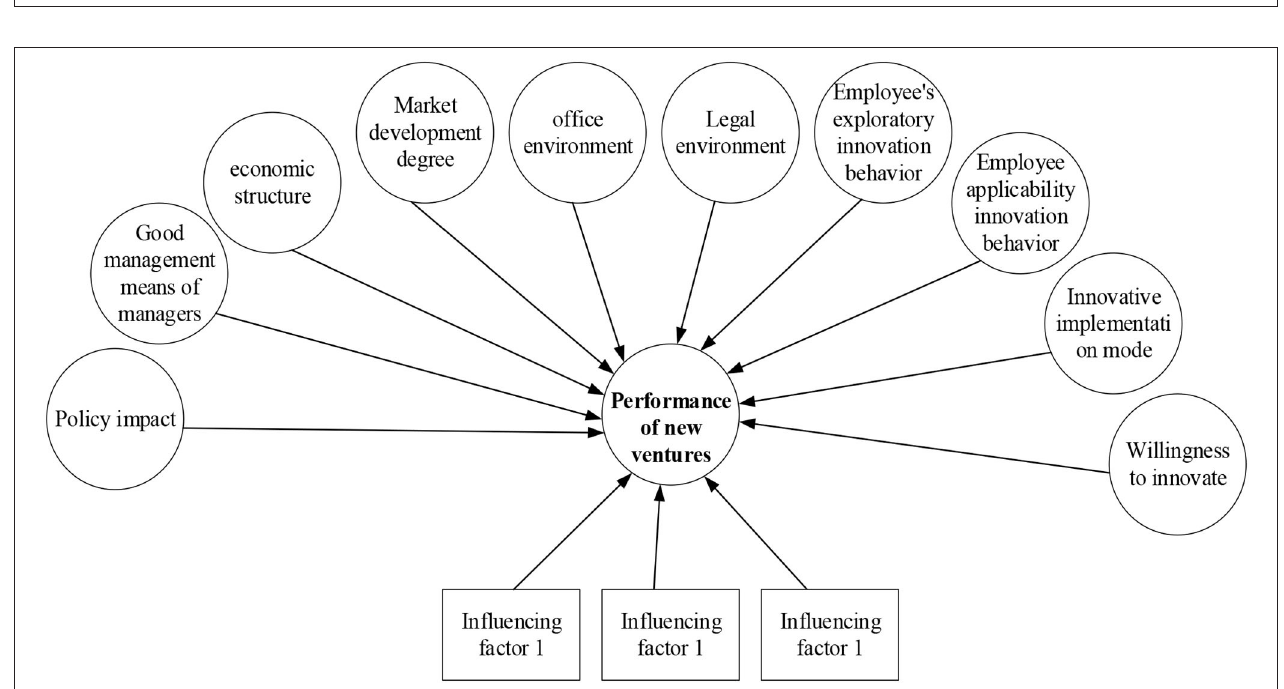
FIGURE 2 | Model of the impact of working environment and innovation behavior on business performance.